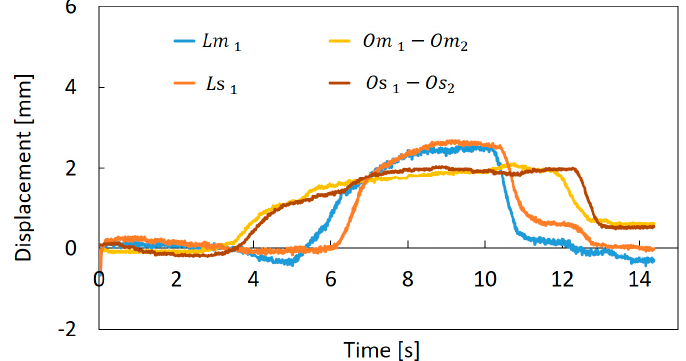
Figure 15. Comparison of the encoder values between the master machine and the slave machine for the composite motion.